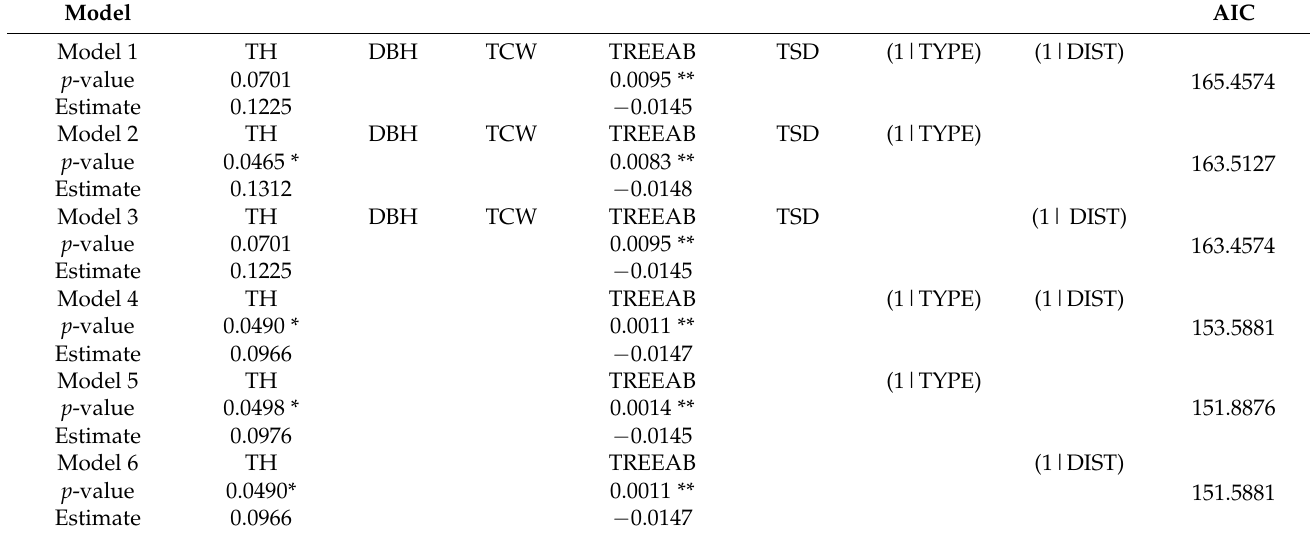
Table 2. The variables used in LMM models, their significance, and the ranking of all models using the Akaike information criterion (AIC) values (from largest to smallest). I. Tree height (TH); II. diameter at breast height (DBH); III. tree crown width (TCW); IV. tree abundance (TREEAB); V. tree species diversity (TSD); VI. sample site types (1|TYPE), 1: farmland shelterbelt, 2: street trees;